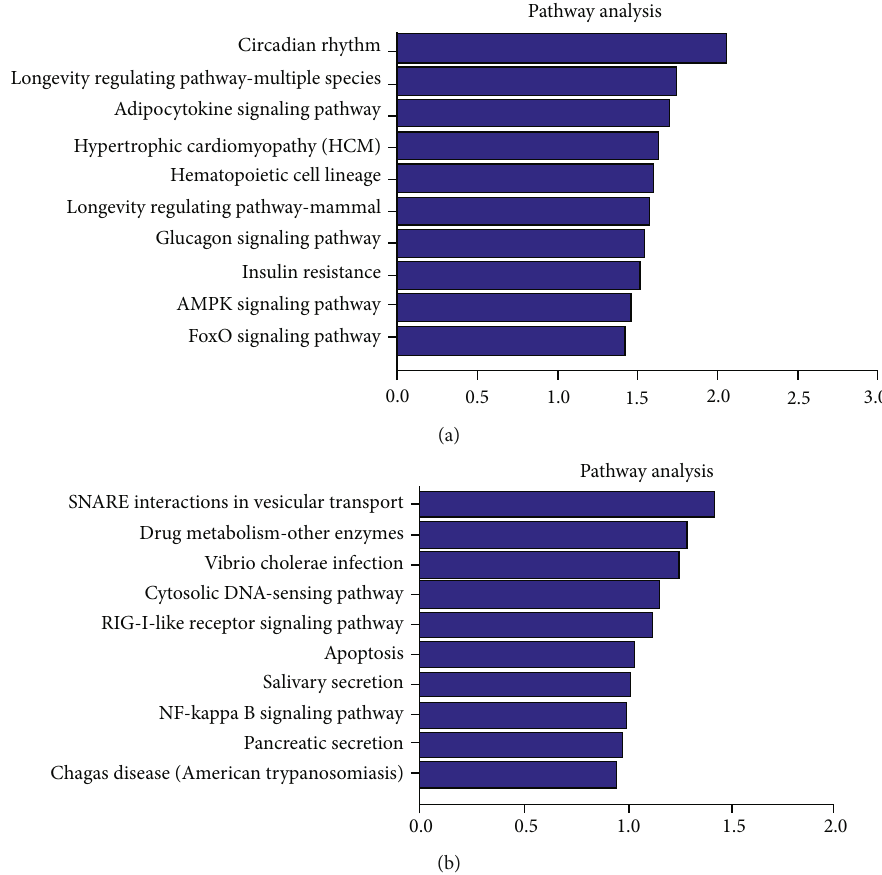
Figure 3: KEGG pathway analysis of di ff erentially expressed lncRNAs. KEGG analysis showed 32 signalling pathways related to the dysregulated lncRNAs in GD. (a) The top 10 KEGG pathways of overexpressed lncRNAs. (b) The top 10 KEGG pathways of downregulated lncRNAs.